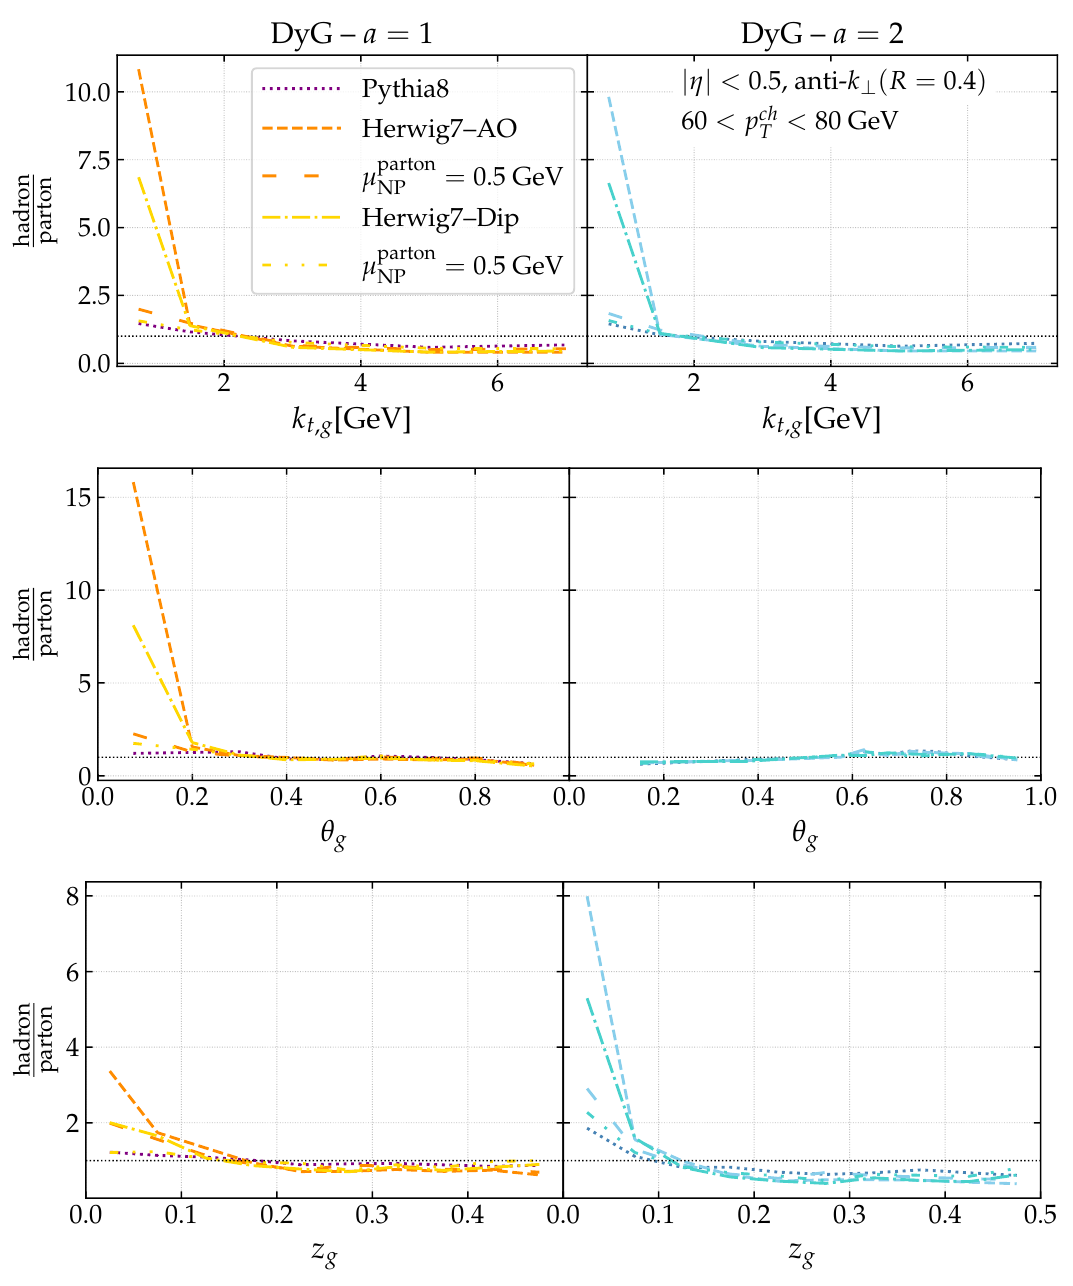
Figure 13 . Ratio of hadron-to-parton level distributions for k t,g (top), θ g (middle) and z g (bot- tom) with five different Monte-Carlo settings: Pythia8 (dotted, purple), Herwig7-AO with default parameters (orange, dashed) and with the shower cut-off set to 0 . 5 GeV at parton level only (orange, loosely dashed), Herwig7-Dip with default parameters (gold, dotted dashed) and with the shower cut-off set to 0 . 5 GeV at parton level only (gold, loosely dotted